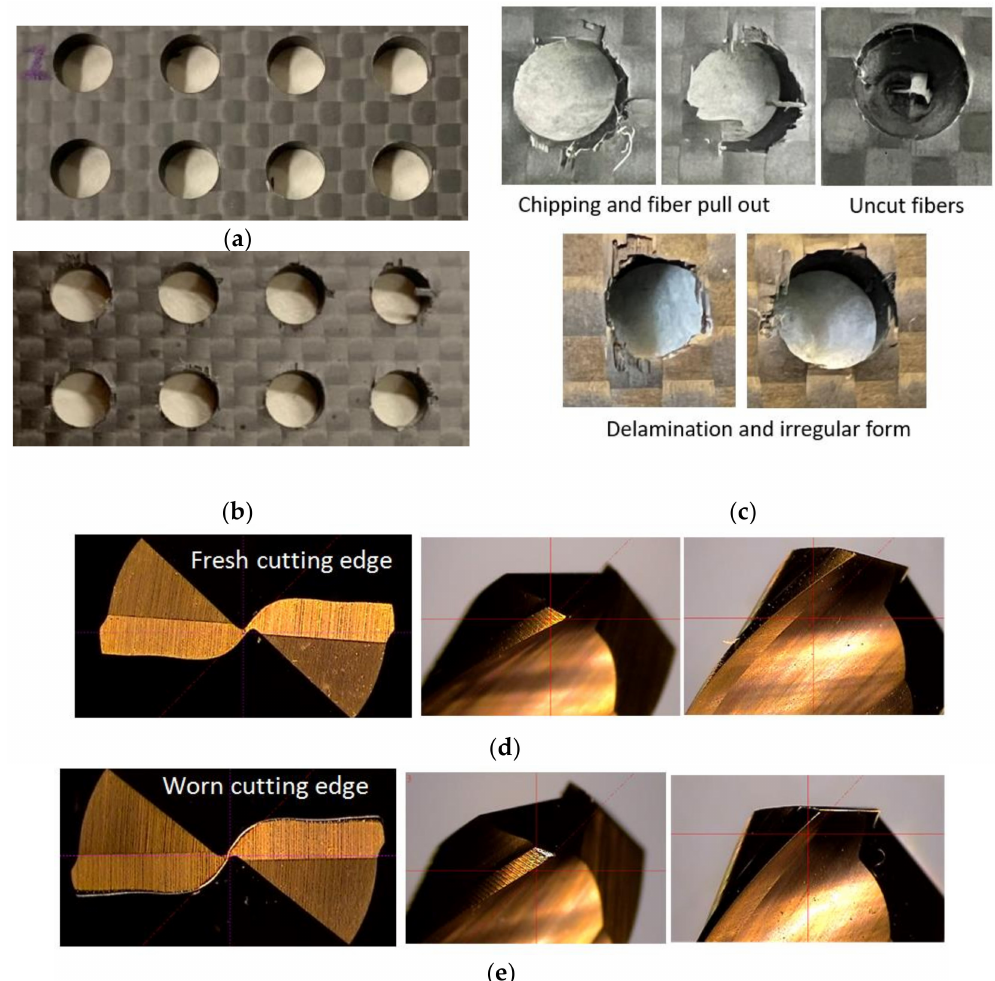
Figure 9. Photos of drilled CRFP laminates and microscopic graphs of the flank edge of a tool. ( a ) Entry surface of drilled holes, ( b ) exit surface of drilled holes with delamination and peripheral burrs, ( c ) damage patterns, ( d ) fresh cutting edge, ( e ) worn cutting edge after 25 holes.